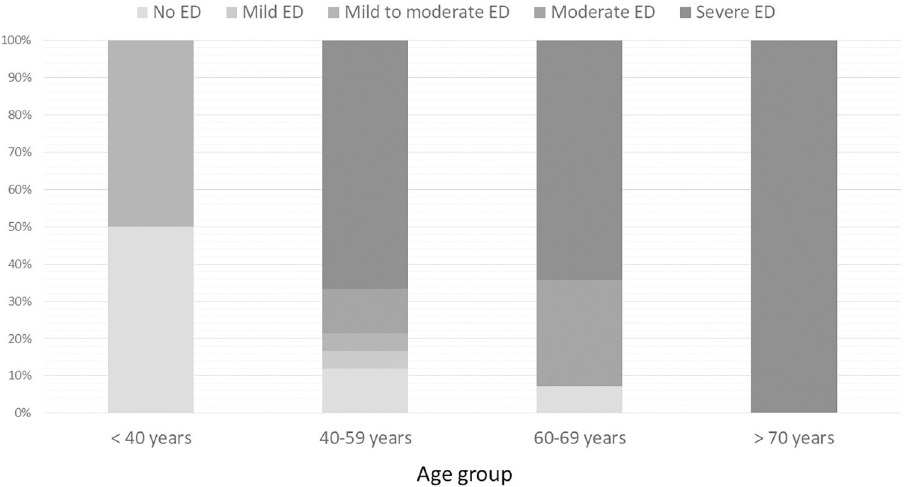
Fig 2. Severity of ED classified by age group. ED erectile